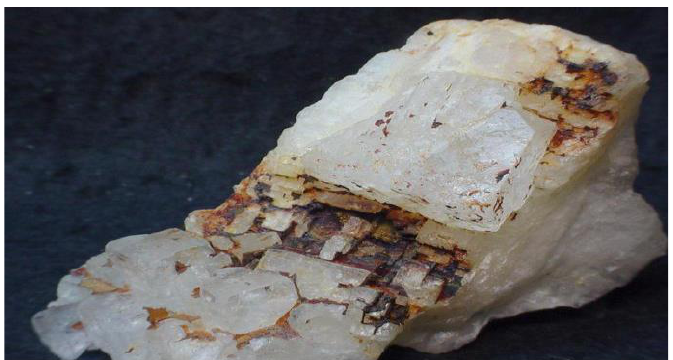
Figure 5. Bauxite